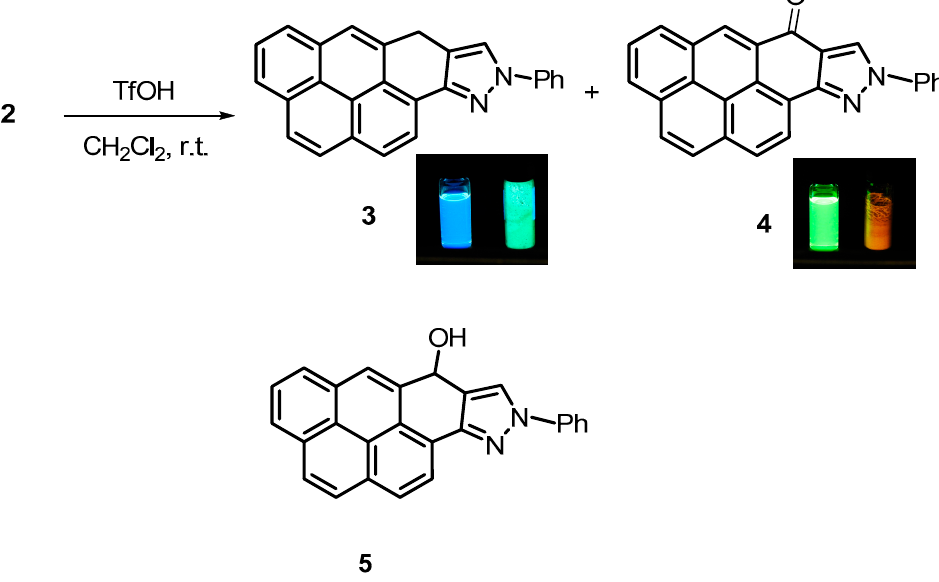
Figure 2. Structures of ( 5H )-olympicene [27] and “pyrazolympicene”.